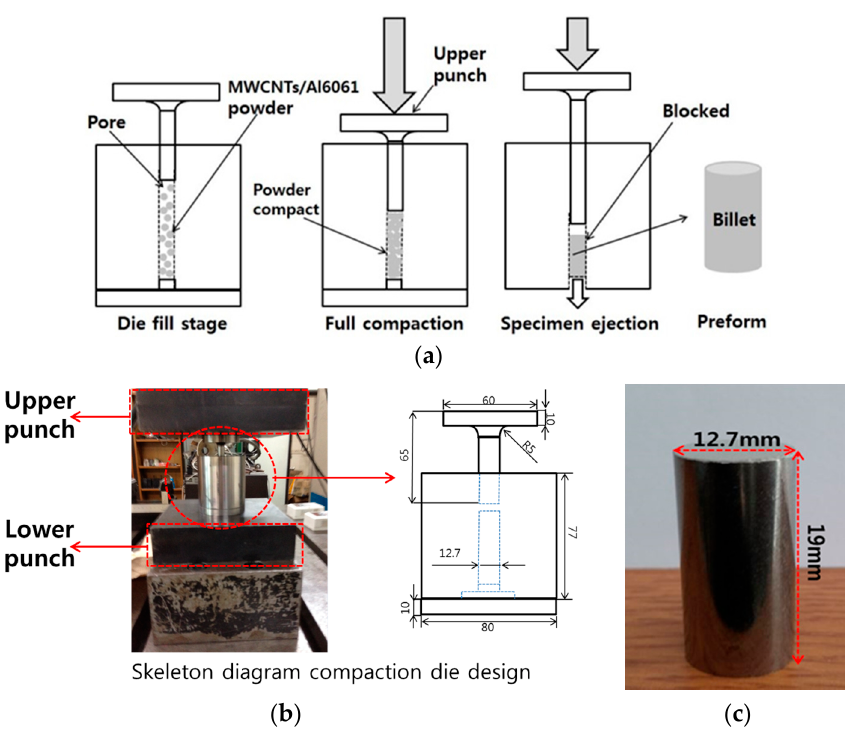
Figure 2. ( a ) Cold-compaction process; ( b ) equipment (unit: mm); and ( c ) billet.